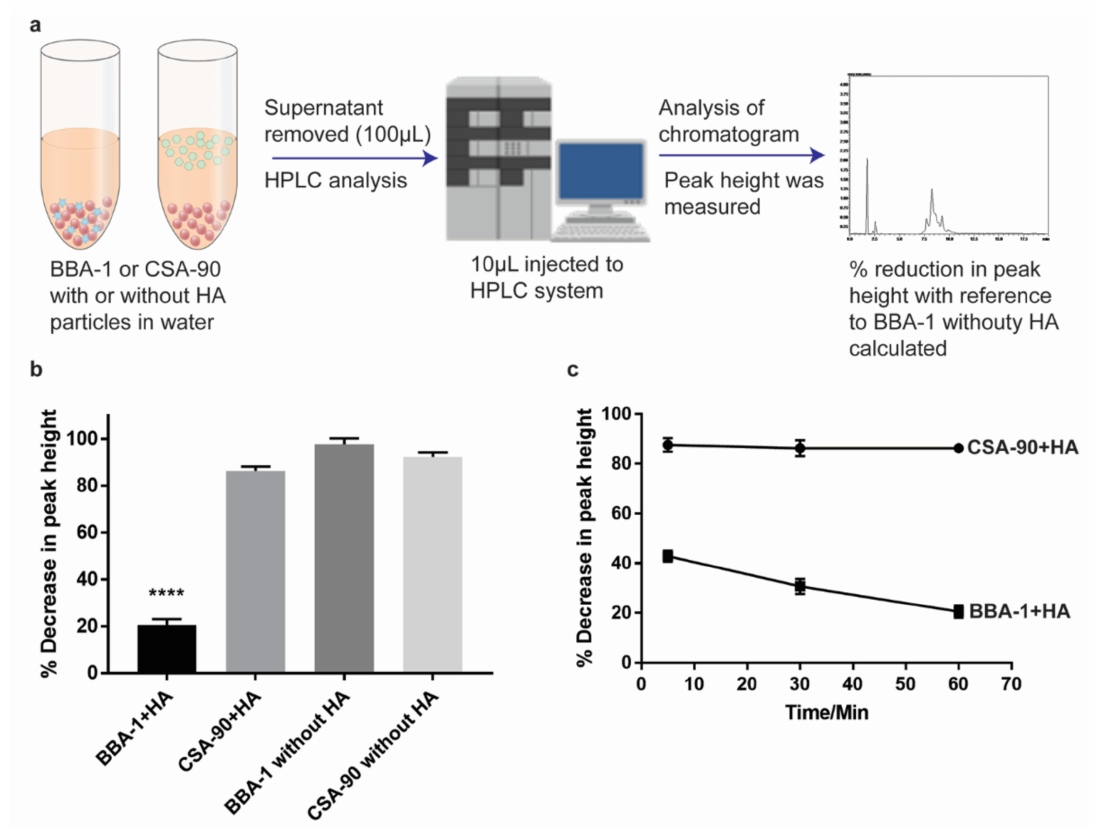
Figure 6. Hydroxyapatite (HA) binding affinity of BBA-1 and parent compound CSA-90. ( a ) Schematic of the experimental procedure. ( b ) HA affinity of BBA-1 and CSA-90 after 60 min of incubation in HA suspension. ( c ) Binding kinetics for BBA-1 and CSA-90 on HA over 60 min. **** Significantly different ( p < 0.001, Tukey’s multiple comparison test, one-way ANOVA, n = 3 independent